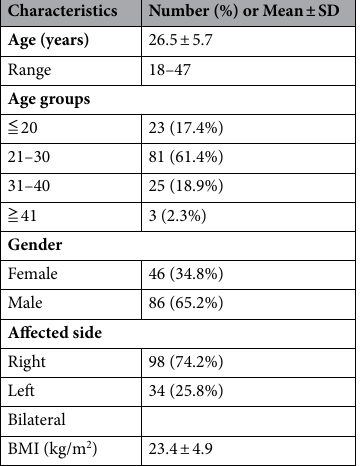
Table 1. Demographic and clinical characteristics of participants. This study and the manuscript with DOI number “https:// doi. org/ 10. 1186/ s12891- 020- 03314-1” published by the same research team used the same cohort of Chinese CAI patients. BMI body mass index.